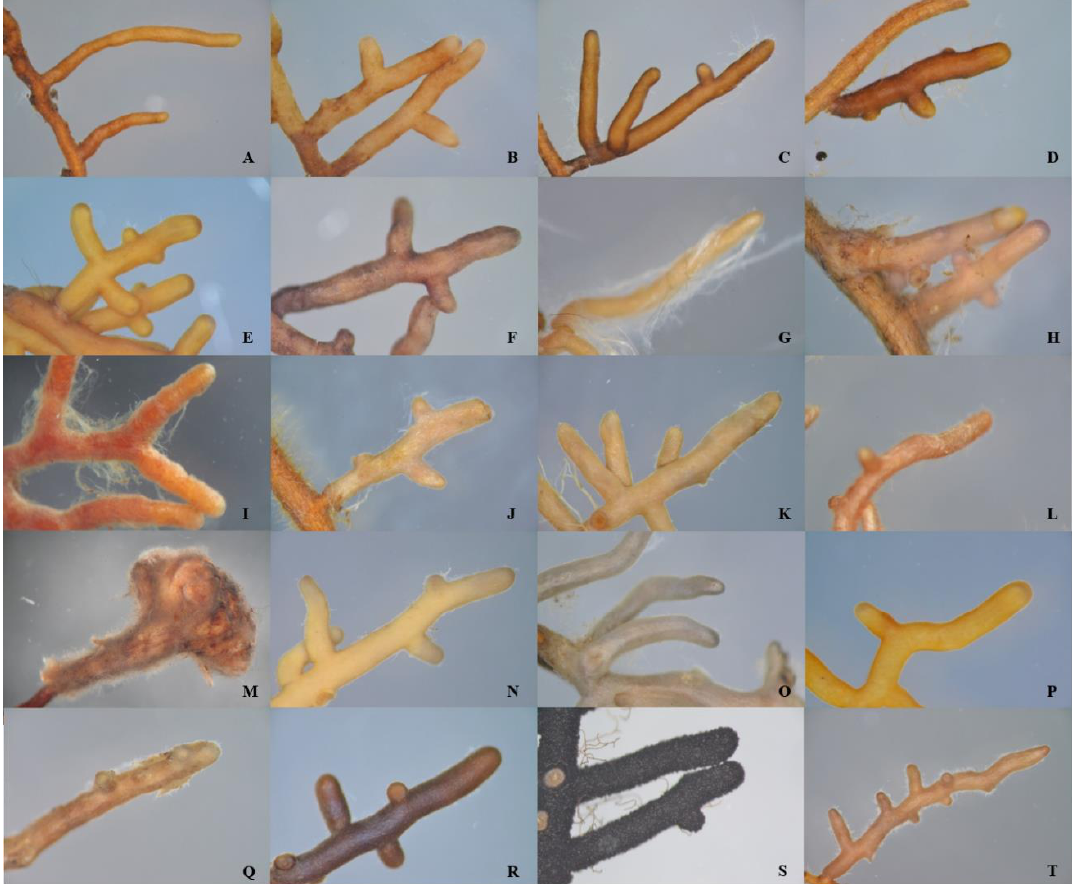
Figure 1. The photographed ectomycorrhizae of taxa used in the study. ( A ) Elaphomyces muricatus Fr.; ( B ) Pachyphloeus sp.; ( C ) Genea hispidula Berk. ex Tul. & C. Tul.; ( D ) Humaria hemisphaerica (F.H. Wigg.) Fuckel; ( E ) Tuber puberulum Berk. & Broome; ( F ) Amanita rubescens Pers.; ( G ) Cortinarius torvus (Fr.) Fr.; ( H ) Laccaria amethystina Cooke; ( I ) Piloderma sphaerosporum Jülich; ( J ) Imleria badia (Fr.) Vizzini; ( K ) Xerocomellus cisalpinus (Simonini, H. Ladurner & Peintner) Klofac; ( L ) Paxillus involutus (Batsch) Fr.; ( M ) Suillus variegatus (Sw.) Richon & Roze; ( N ) Craterellus cornucopioides (L.) Pers.; ( O ) Clavulina coralloides (L.) J. Schröt; ( P ) Lactarius aurantiacus (Pers.) Grey; ( Q ) Russula nigricans Fr.; ( R ) Tomentella sp.1; ( S ) Tomentella sp.2; ( T ) Tomentella terrestris (Berk. & Broome) M.J. Larsen .